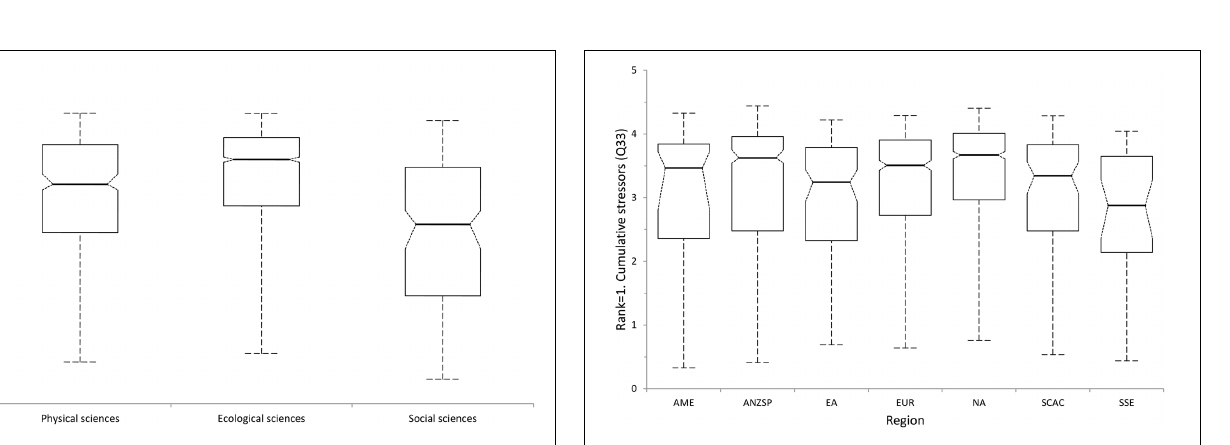
FIGURE 2 | Box plot of median ranking score for top-ranked question (cumulative stressors) for each of three disciplinary categories.